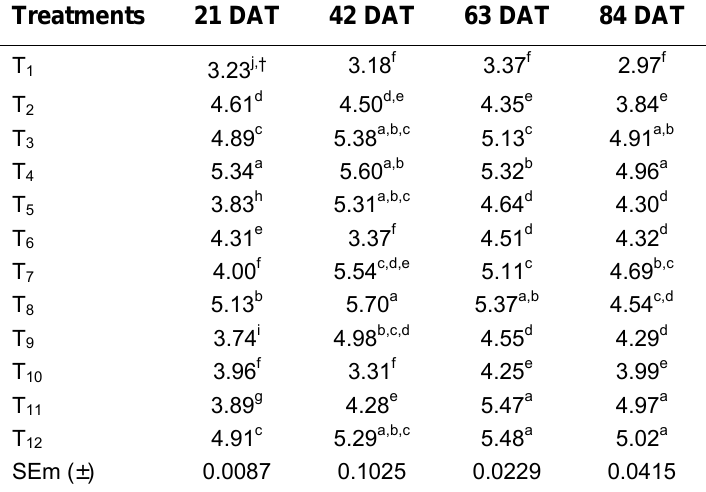
Effect of Different Treatments of N on LCC Readings in Rice (Pooled Mean of 2001–2002 and 2002–2003) Treatments 21 DAT